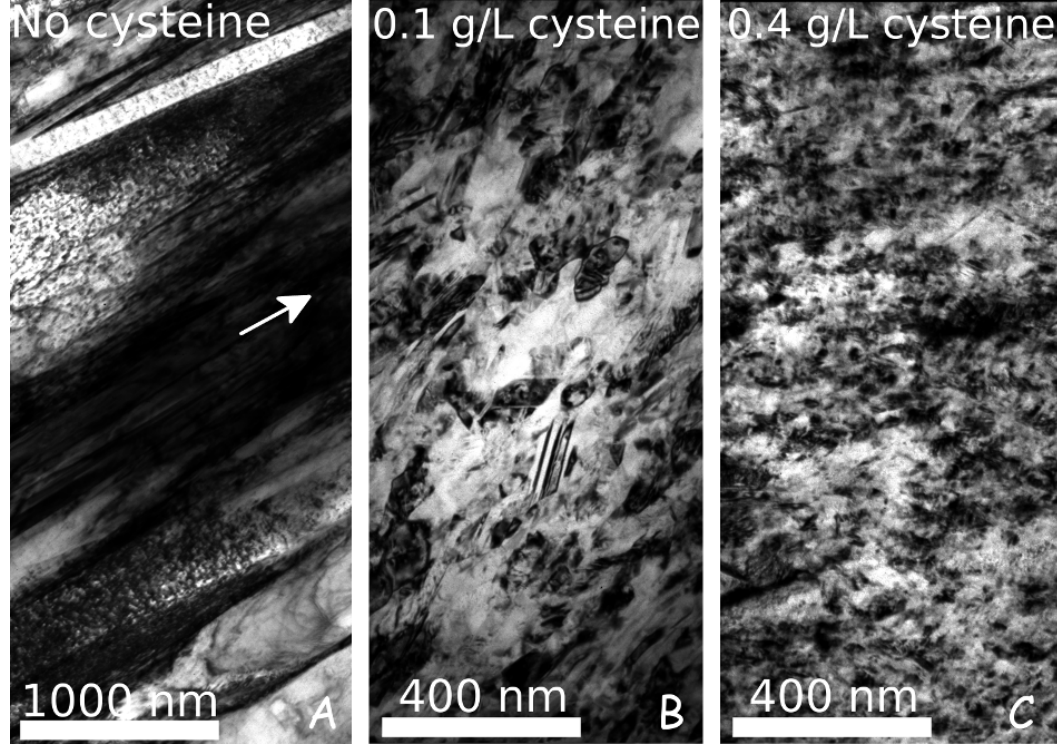
Figure 1. TEM images showing the microstructures in the cross section of the Ni films (close to the electrolyte side) processed without cysteine ( A ), 0.1 g/L cysteine ( B ) and 0.4 g/L cysteine ( C ). The white arrow in ( A ) indicates the growth direction of the